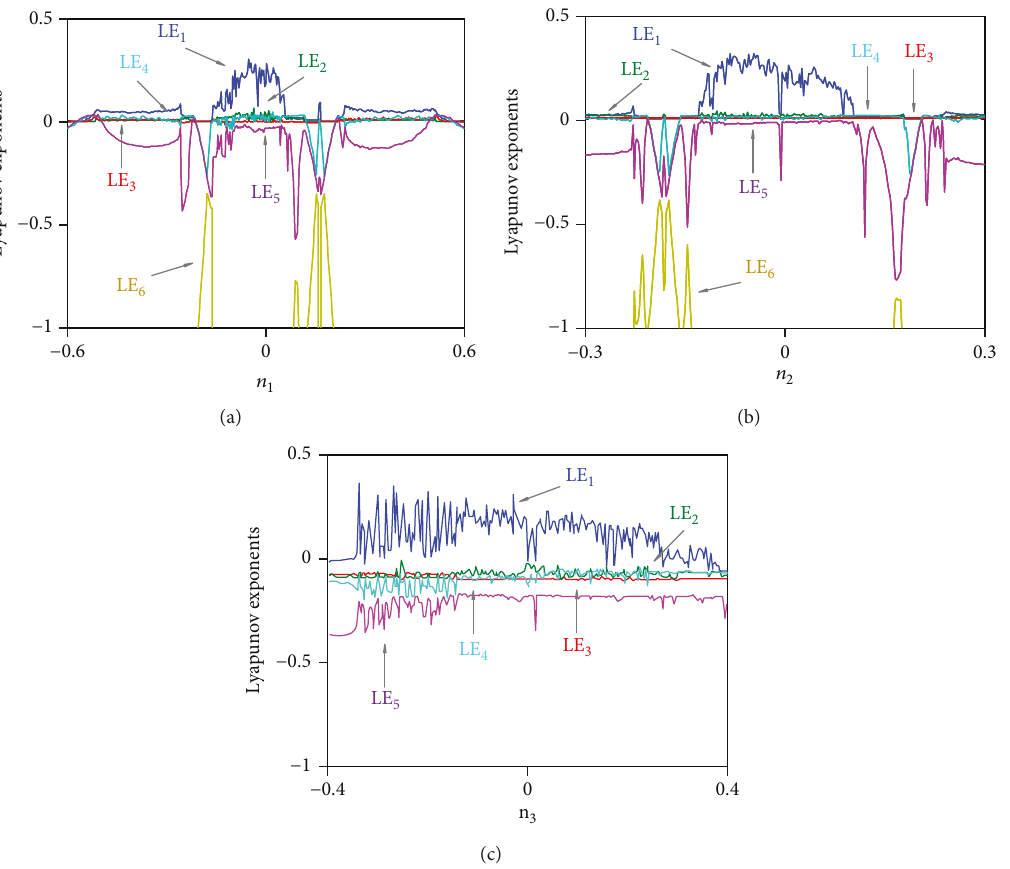
Figure 5: Lyapunov exponent spectrum with varying initial states n